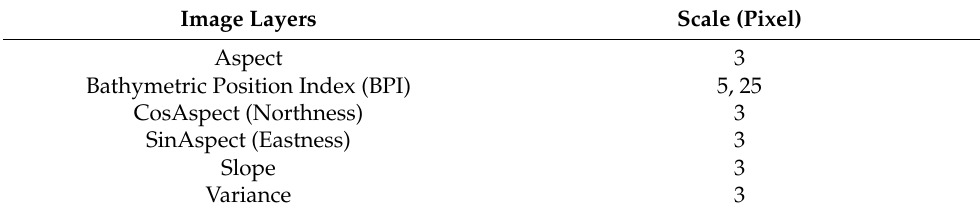
Table 1. Image layers used for segmentation in eCognition